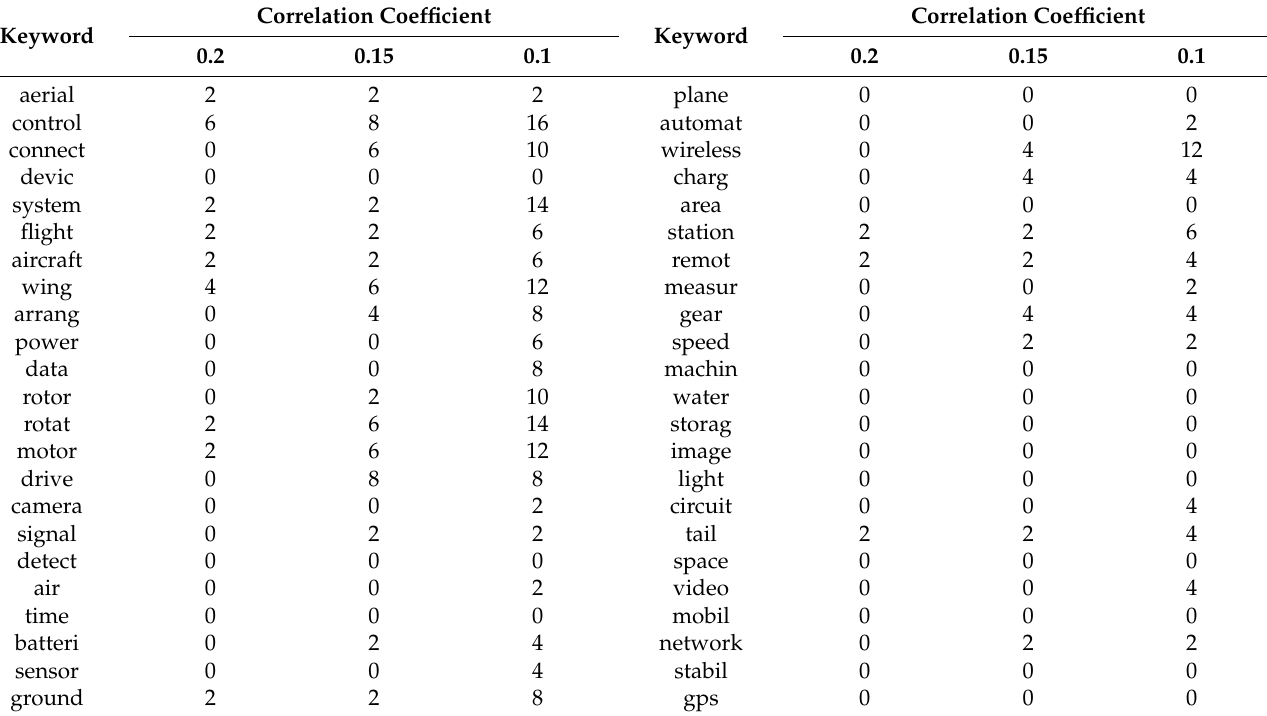
Table 4. Degrees of top 60 keywords of drone technology.